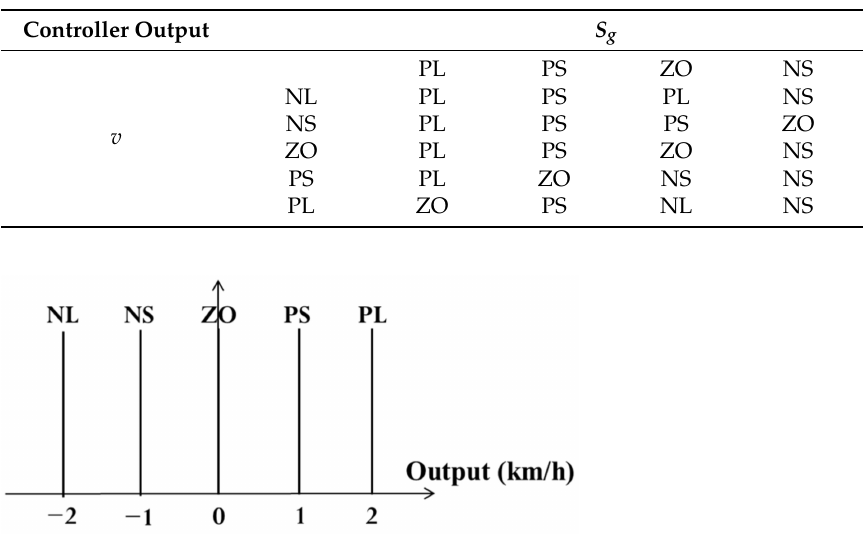
Figure 6. Input membership functions. Table 1. Fuzzy rule base (without user’s posture).